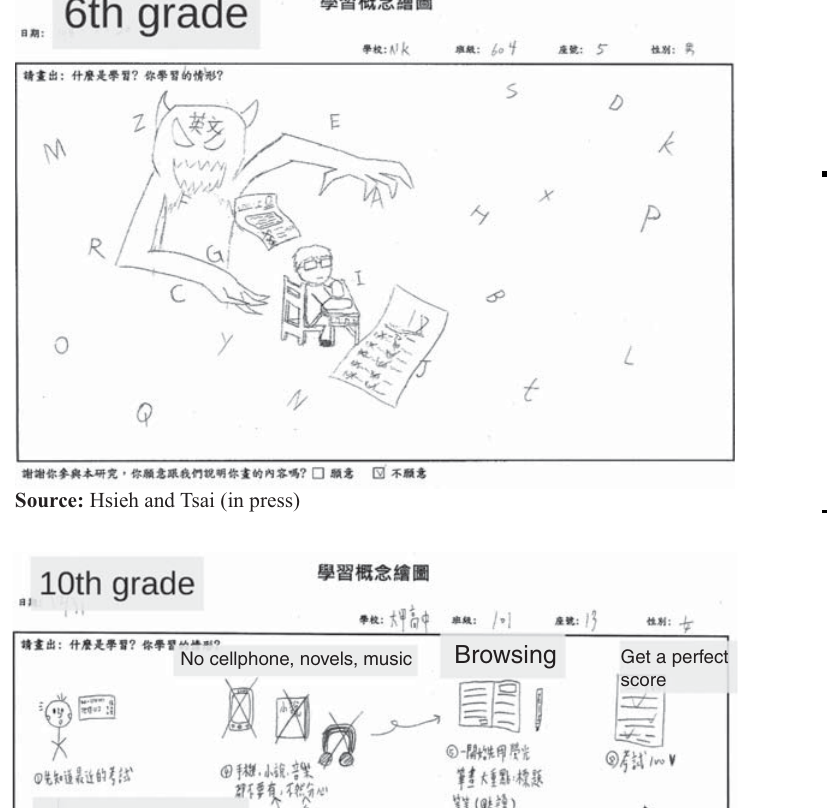
Figure 16. A drawing by a 10th grade student showing her